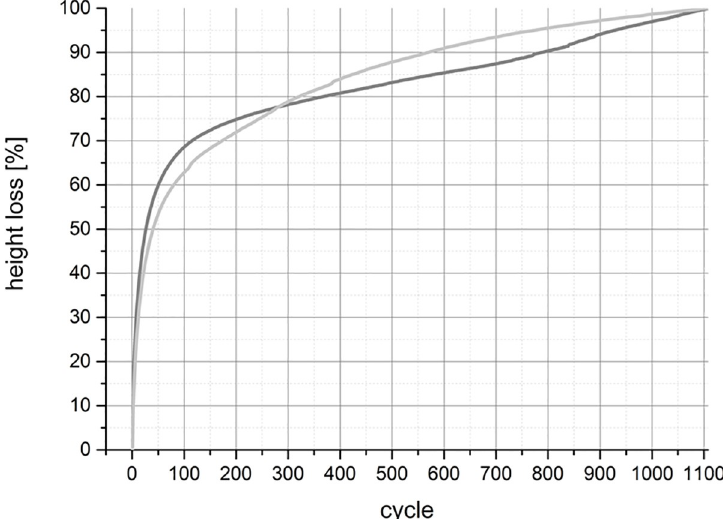
Fig 7. A comparison of the proportional HL during tribological exposure between the old group in dark grey and the young group in light grey averaged over all specimens. The specimens originating from old animals lost their proportional height a little more rapidly. However, the total loss of cartilage was lower (Fig 6). Throughout the first 100 cycles, both groups lost a major part of their initial height. After 100 cycles, the slope’s gradients indicating the rapidity of height